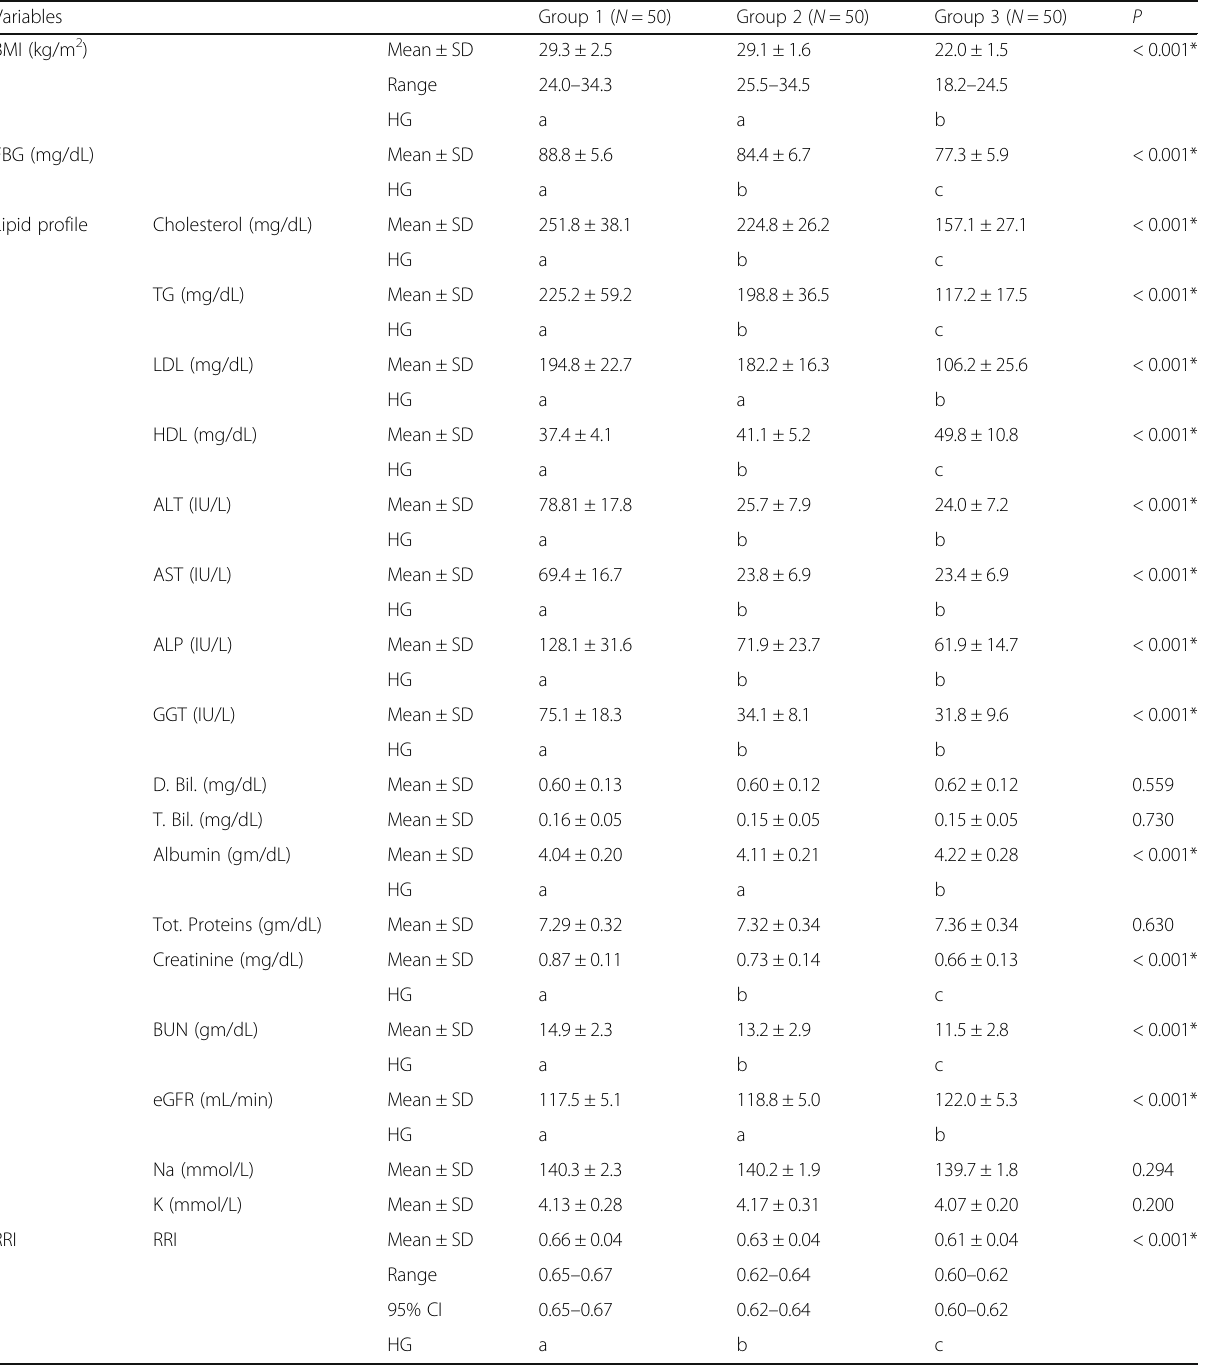
Table 1 Comparison between the three groups regarding the studied variables using ANOVA test